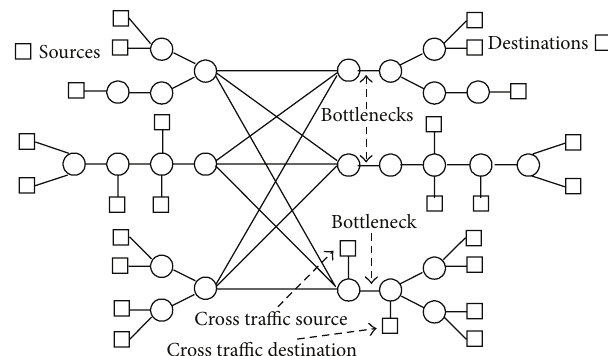
Figure 7: Topology without common